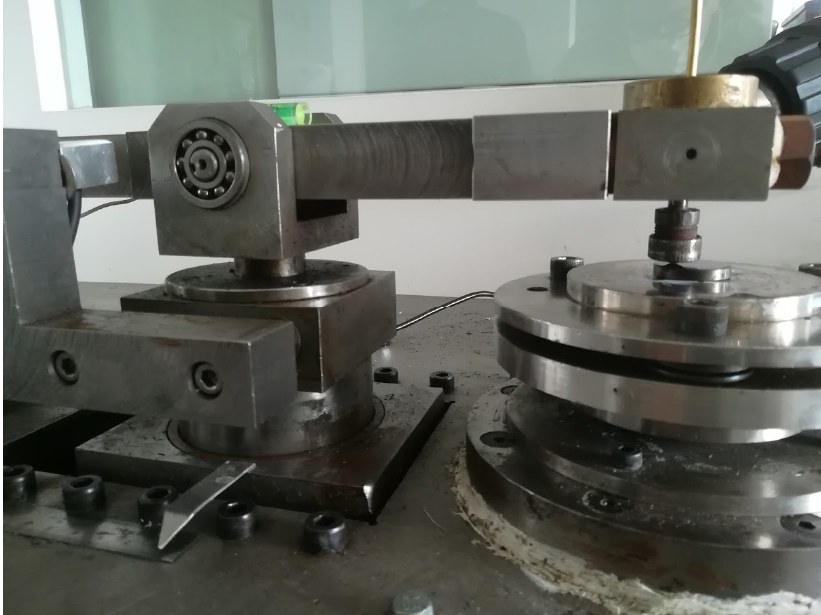
Figure 1. Customized pin-on-disk (POD) machine utilized for tribological testing.